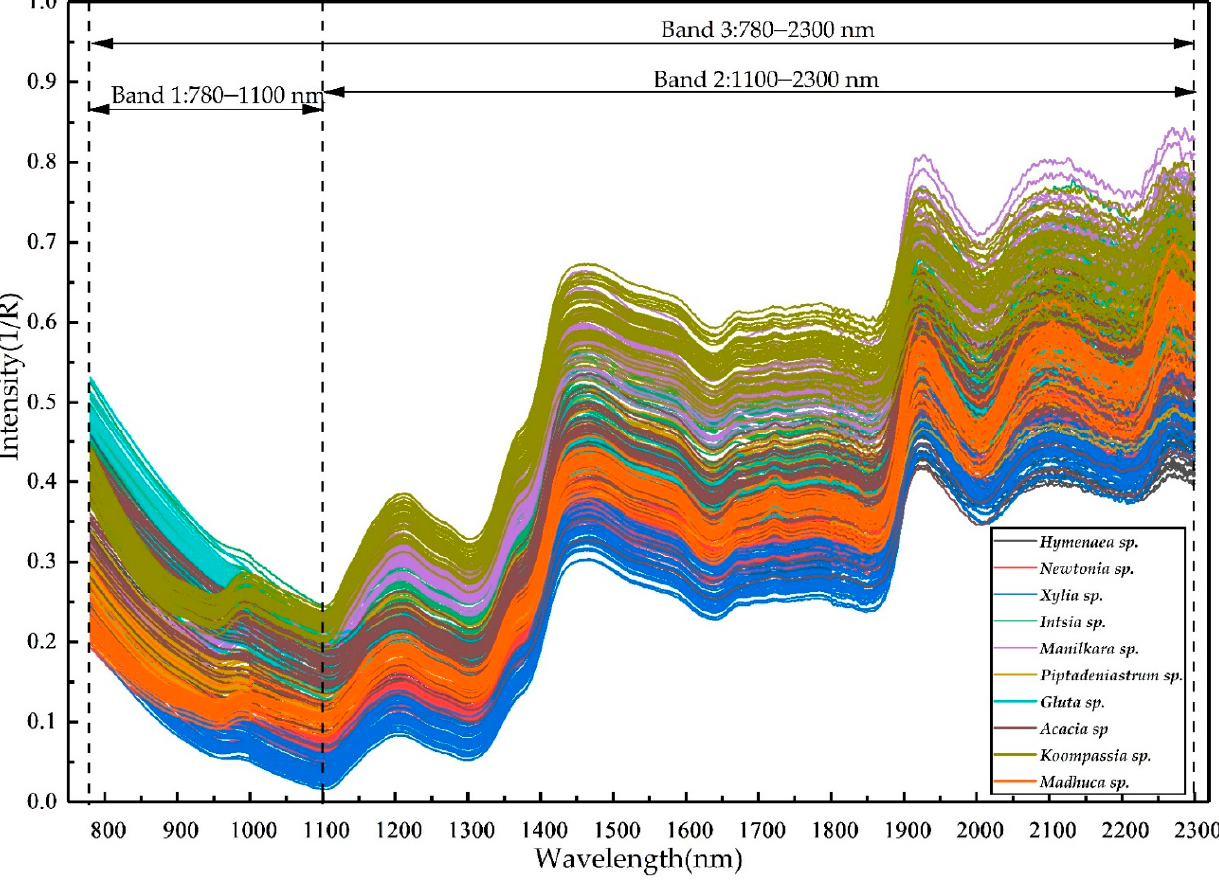
Figure 1. The raw NIR spectra of the transverse section of the first ten wood samples.